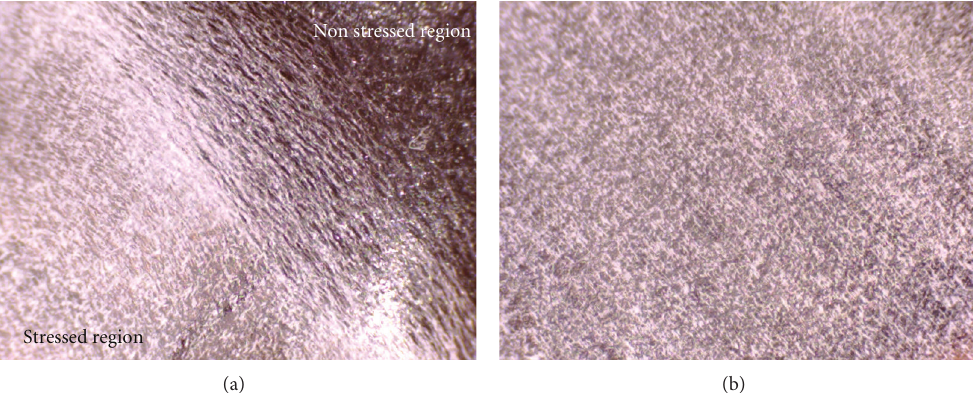
F 6: Optical microscopic images of the stress whitening (a) comparison of nonstressed and stressed regions, (b) closer view of the microvoid formation.